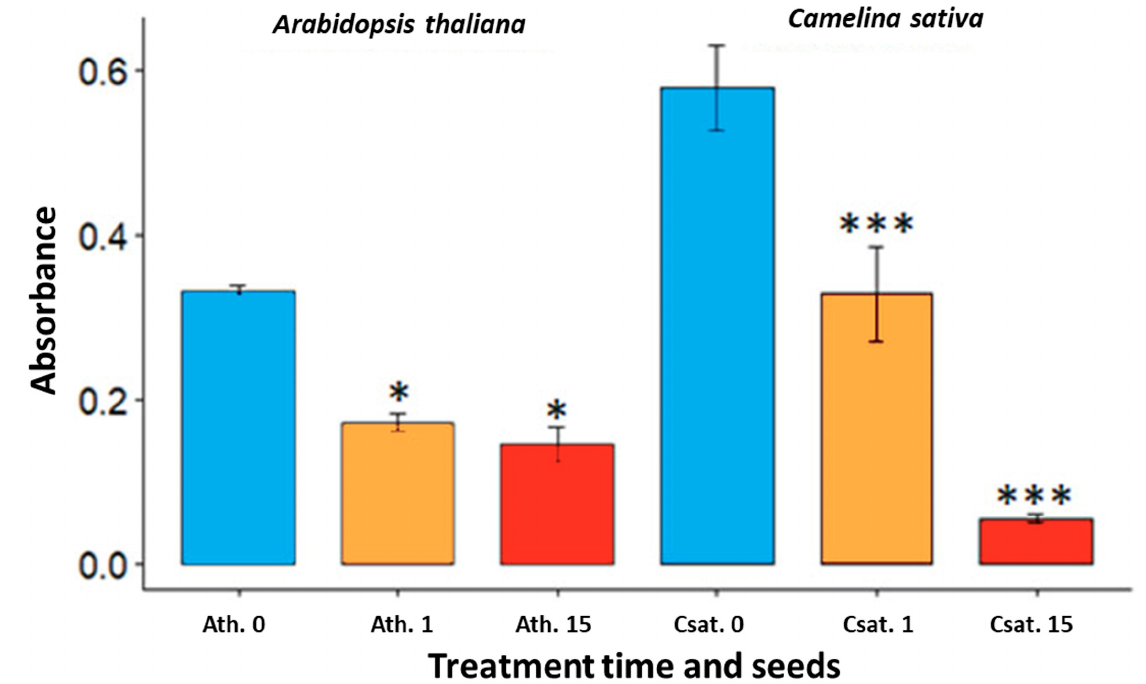
Figure 4. Bar plots of permeability tests with tetrazolium red on A. thaliana and C. sativa seeds after different plasma treatment times. Seeds were incubated for 24 h in tetrazolium red at 28 °C and the production of formazan is noted by measuring the absorbance of the incubation solution at 492 nm. The blue bars represent the control samples, the orange curves the air plasma treated seeds during 1 min and the red ones the 15 min treated seeds. On the left side, the absorbance for the A. thaliana seeds (Ath. 0, 1 and 15 min), and on the right the absorbance for the C. sativa seeds (Csat. 0, 1 and 15 min). The significant differences were determined using the Wilcoxon test between the control and plasma treated seeds: *: p-value < 0.01 ***: p -value < 0.001.